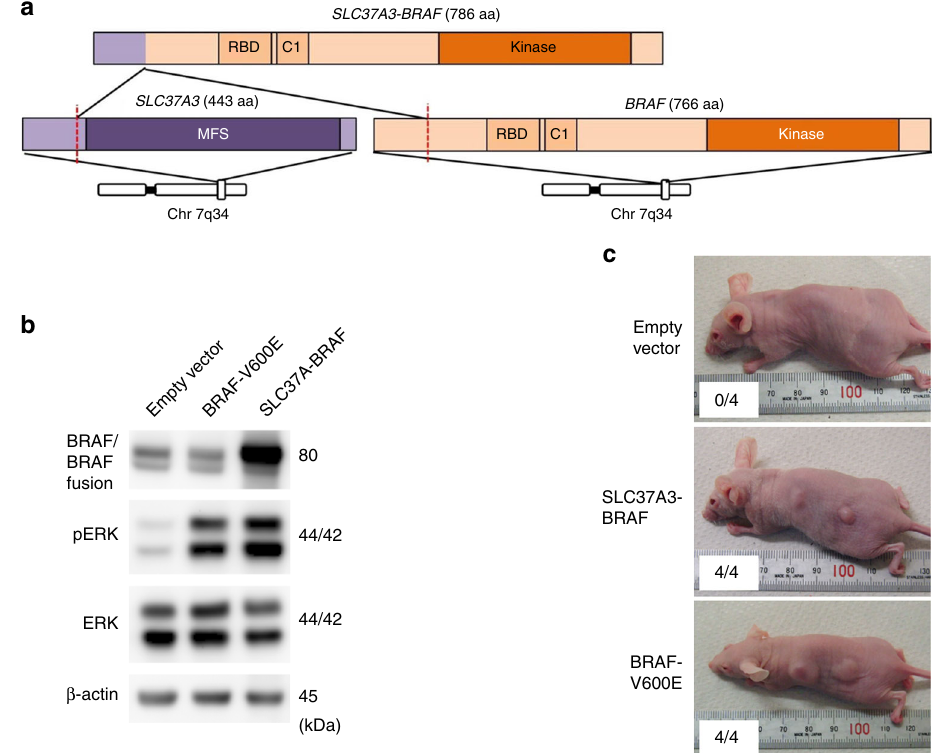
Fig. 3 Oncogenic BRAF fusion gene detected in MFS. a Schematic presentation of the proteins encoded by SLC37A3 , BRAF , and SLC37A3-BRAF fusion gene. MFS major facilitator superfamily, RBD RAS-binding domain, C1 phorbol esters/diacylglycerol-binding domain (C1 domain), Kinase protein kinase. b BRAF fusion induced ERK activation. Proteins extracted from cells transfected with retroviruses containing control, BRAF-V600E , and SLC37A3-BRAF were immunoblotted with antibodies against BRAF, phosphorylated ERK (p-ERK), ERK, and β -Actin. c Tumorigenicity of SLC37-BRAF fusion. Representative images of mice subcutaneously transplanted with NIH3T3 cells expressing empty vector or the SLC37A3-BRAF fusion. NIH3T3 cells transformed with BRAF V600E were used as a positive